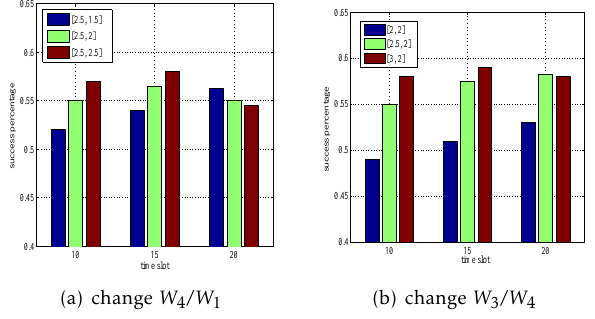
Figure 7. Comparison of success percentage when varying algorithm